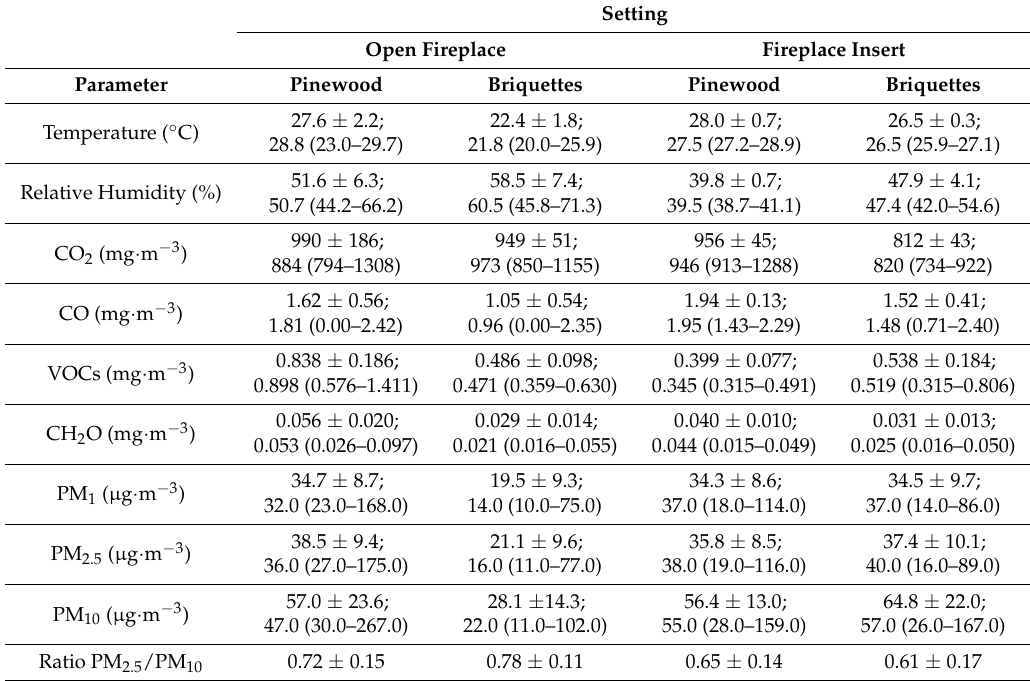
PM X , CO, VOCs, CH 2 O, and CO 2 concentrations before the combustion period: mean ± standard deviation; median